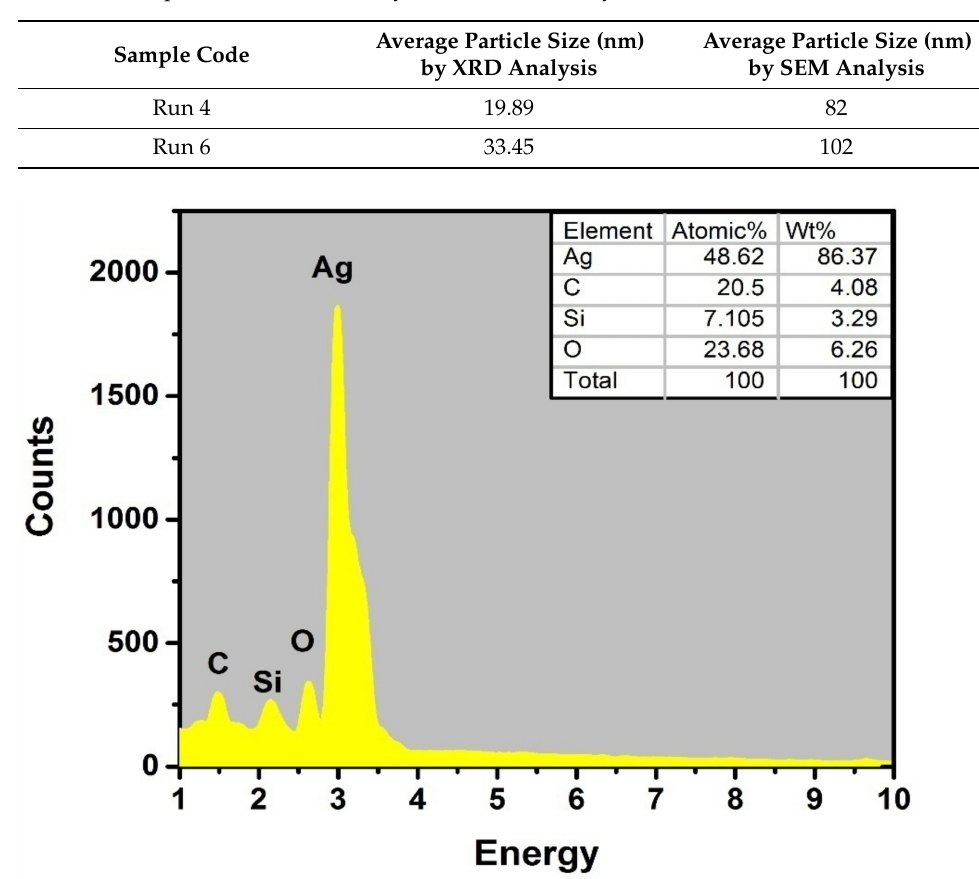
Figure 8. ( a , b ) Size distribution histogram of AgNPs. Table 4. Mean particle size obtained by XRD and SEM analysis.